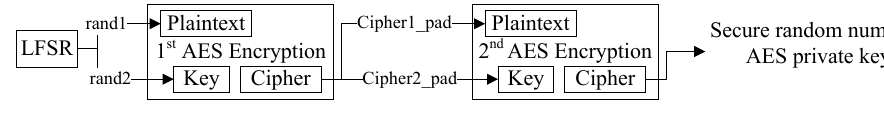
Figure 9. AES-based